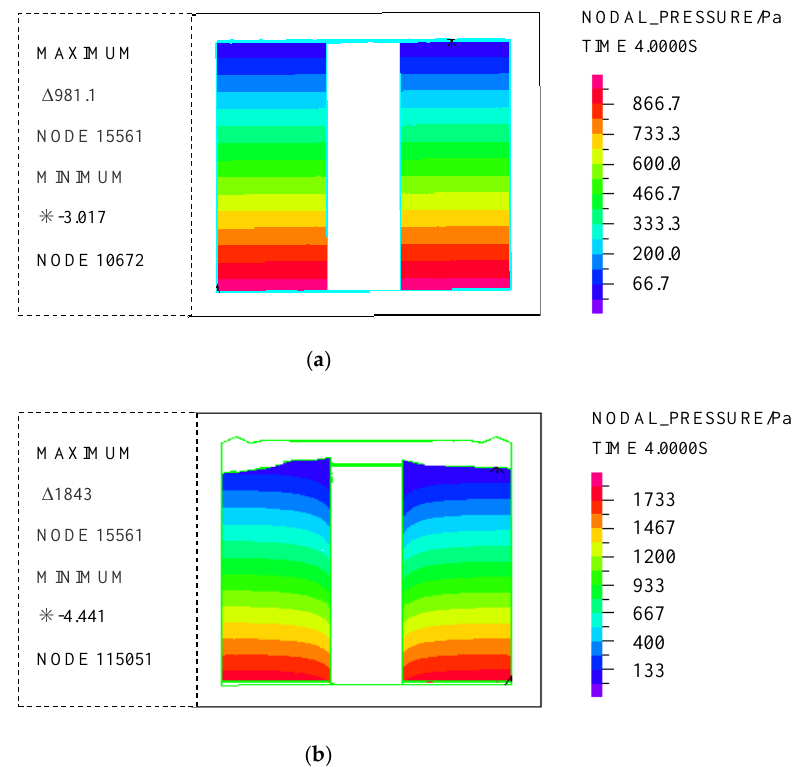
Figure 12. Fluid pressure cross-cutting cloud maps ( a ) Laminar flow model; ( b ) Turbulence model. (2) Comparison of normal disturbance force